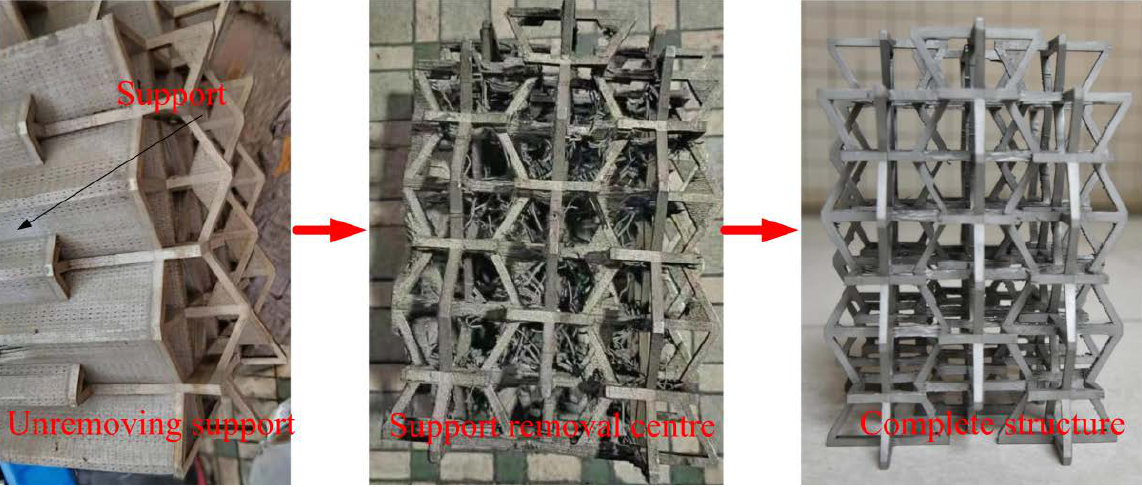
Figure 5. The 316 L NPR structural support-removal process.